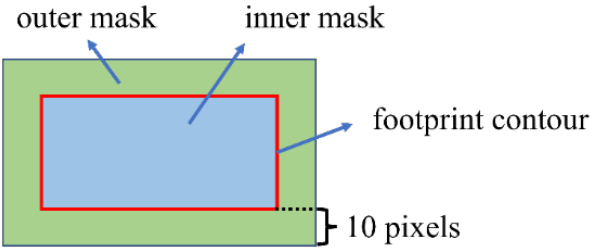
Figure 9. Diagram of inner mask and outer mask. Table 8. Metrics of CNN, MLP, and RF on test set.